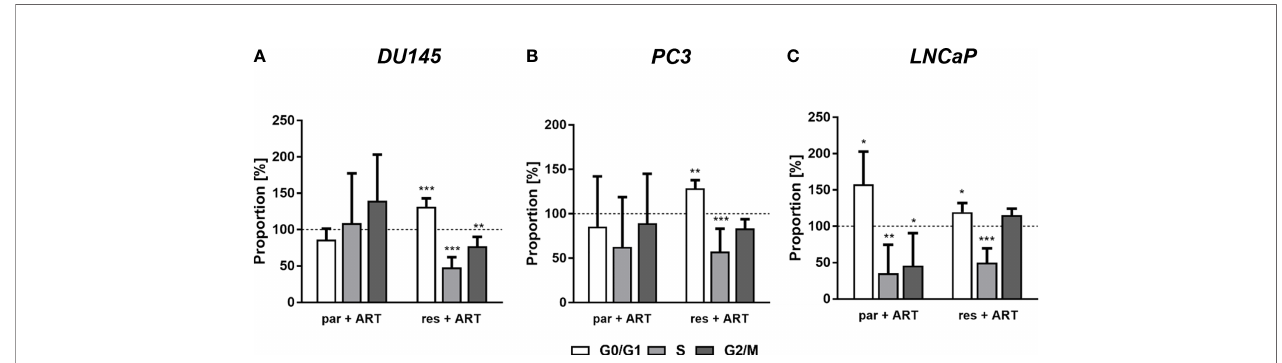
FIGURE 3 | Distribution of cell cycle phases: proportion of parental (par) and DX-resistant (res) PCa cells, DU145 (A) , PC3 (B) , and LNCaP (C) , in the G0/G1, S, and G2/M phases after 48 h ART application [37.5 µM]. Untreated cells served as controls (dotted line set to 100%). Error bars indicate standard deviation (SD). Signi fi cant difference to untreated control: *p ≤ .05, **p ≤ .01, ***p ≤ .001. n